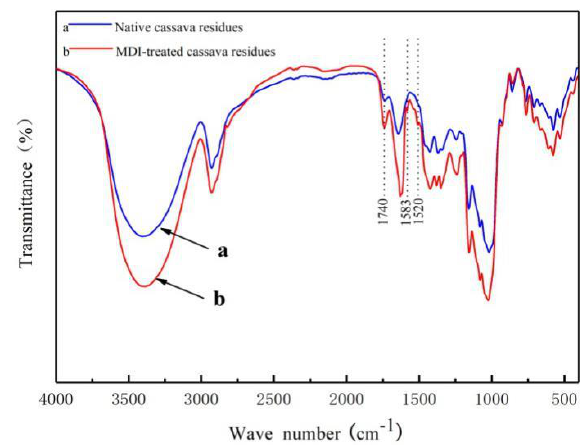
Figure 2. FTIR spectra of cassava residues.